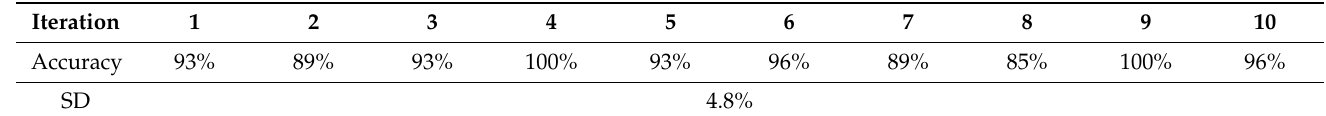
Table 2. Accuracy of the pure STE buffer medium, the influenza A virus in the STE buffer medium, and the influenza B virus in the STE buffer medium spectrum differentiation.